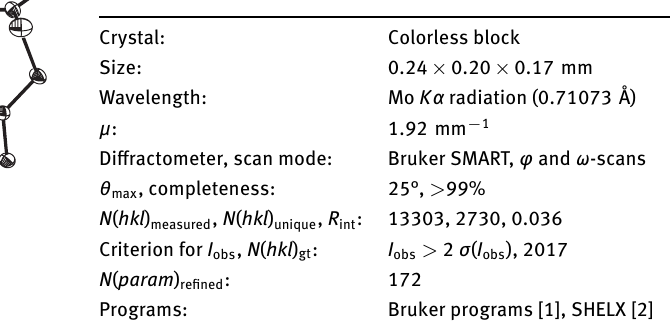
Table 1: Data collection and handling.